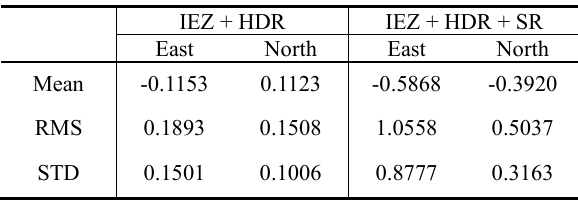
Table 1 . Horizontal positioning errors (Experiment 1).